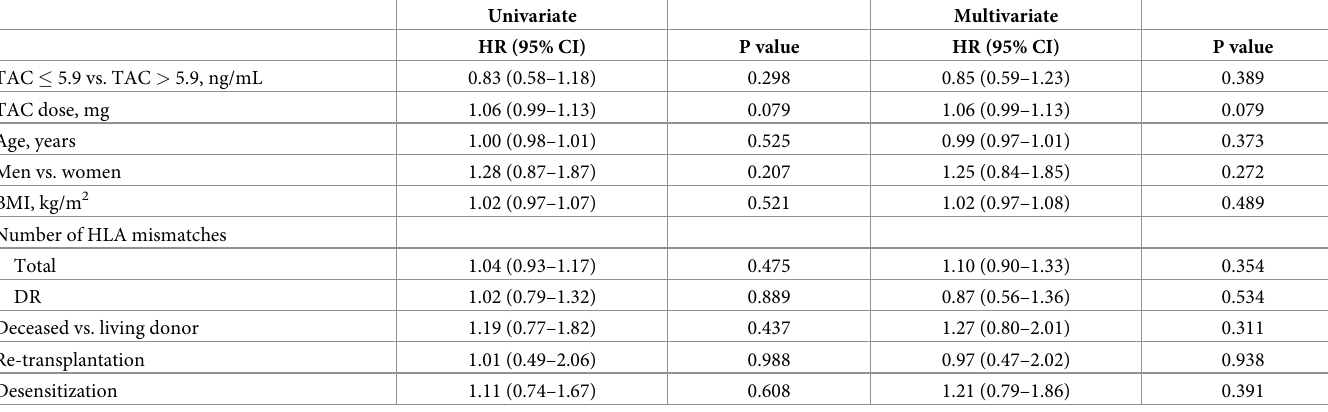
Table 2. Univariate and multivariate Cox regression analysis for renal composite endpoints.